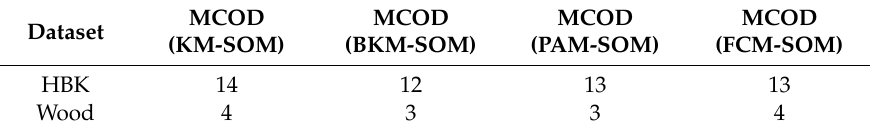
Table 5. The number of true detected outliers